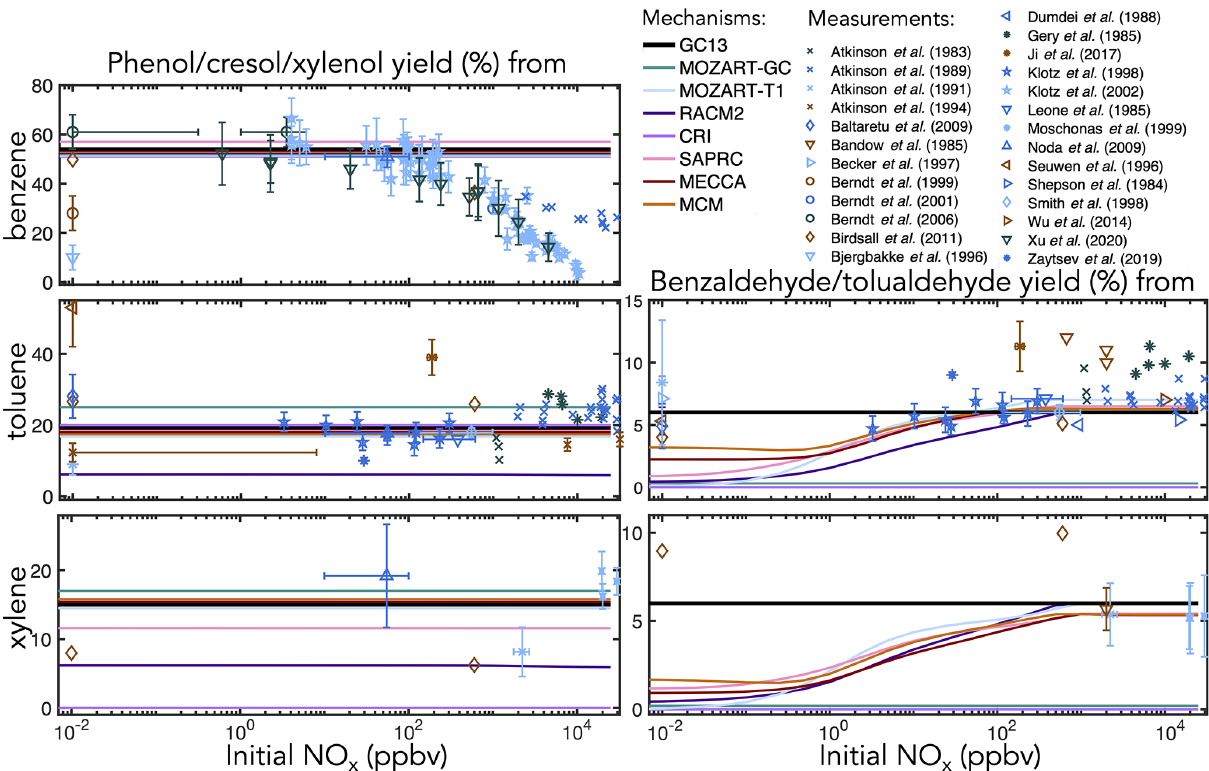
Figure 4. Experimental (points) and simulated (lines) prompt molar yields of aromatic alcohols and aldehydes from BTX oxidation in environmental chambers as a function of initial NO x mixing ratio. Overlapping simulation lines are offset slightly for